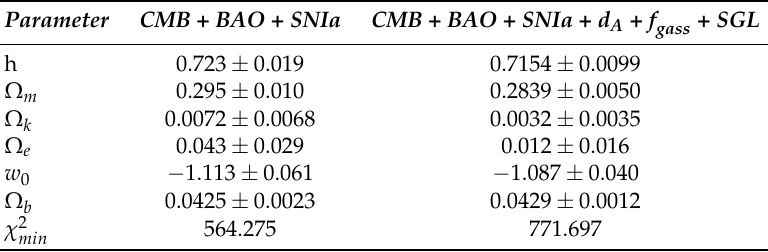
Table 5. Summary of the best fit values for the EDE